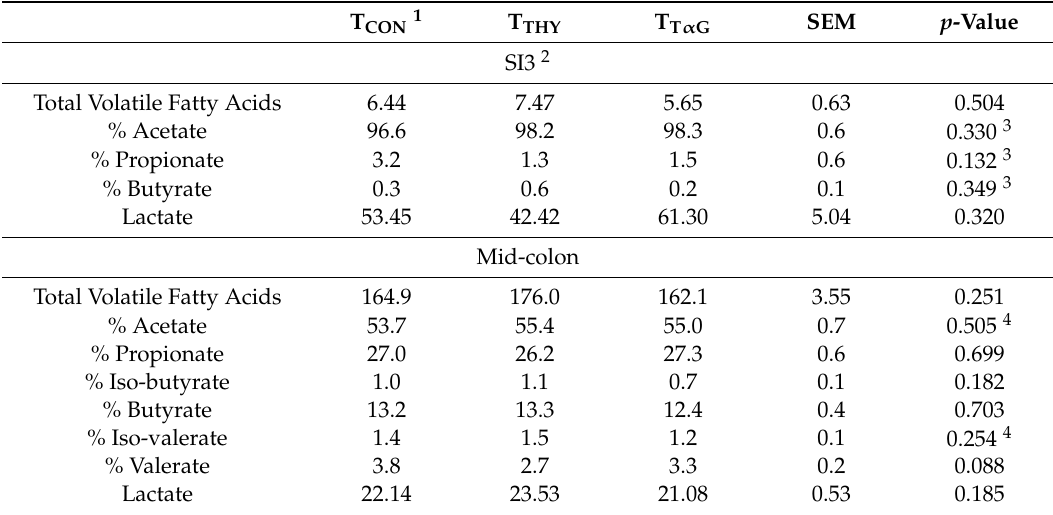
Table 5. The e ff ect of dietary treatment on bacterial metabolites ( µ mol / g) in the small intestine and mid-colon of